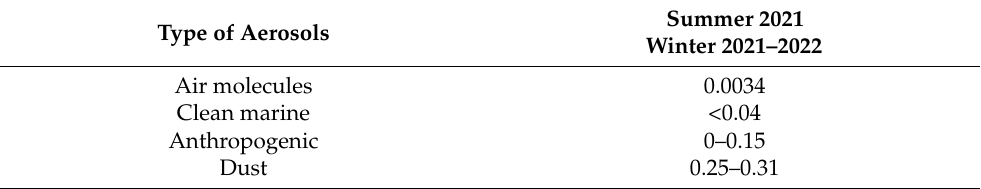
Table 3. Depolarization Ratio values for some aerosol categories at 532